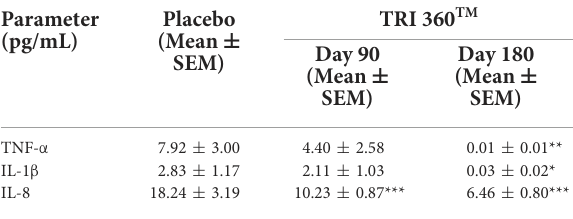
TABLE 5 Measurement of inflammatory cytokines (TNF- α , IL-1 β , and IL-8) in serum after treatment with the proprietary dietary supplement (TRI 360 TM ) capsules in human subjects, measured at days 90 and